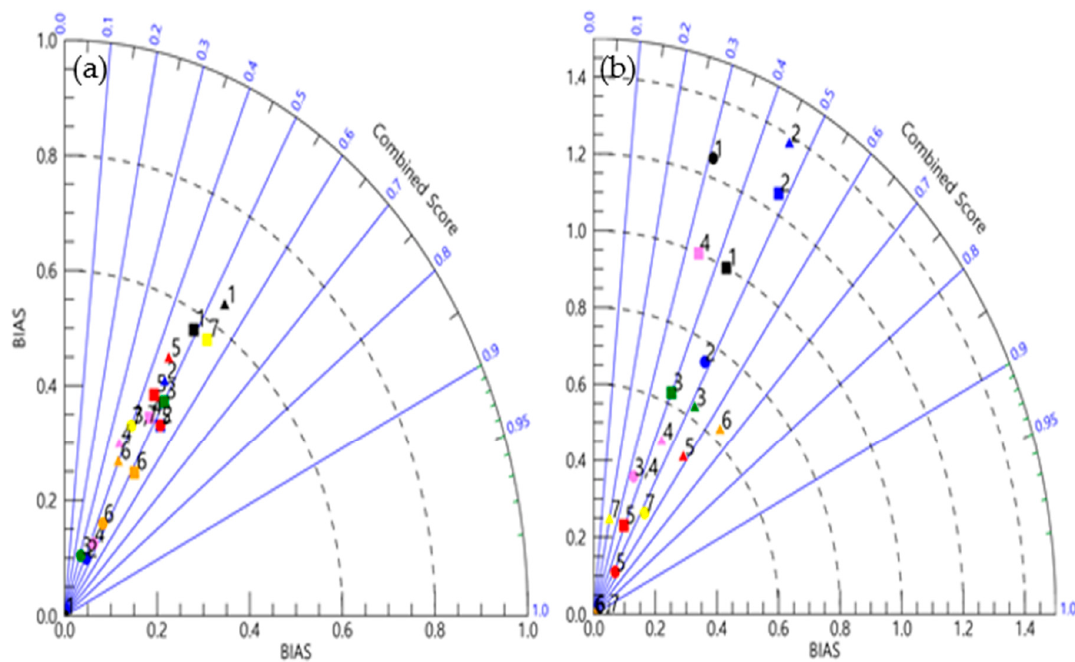
Figure 6. Taylor diagram displaying combined skill score and BIAS for ( a ) wet season and ( b ) dry season. The shapes of square, circle, and triangle represent the resolution of 9 / 3 km, 12 / 4 km, and 15 / 5 km, respectively. The numbers with colors of black, blue, green, magenta, red, orange, yellow in order represent simulations using the same physical parameterization from the simulation 1 to simulation 7. The blue contour represents the azimuthal angle, and the black dashed contour is the radial distance from the origin.